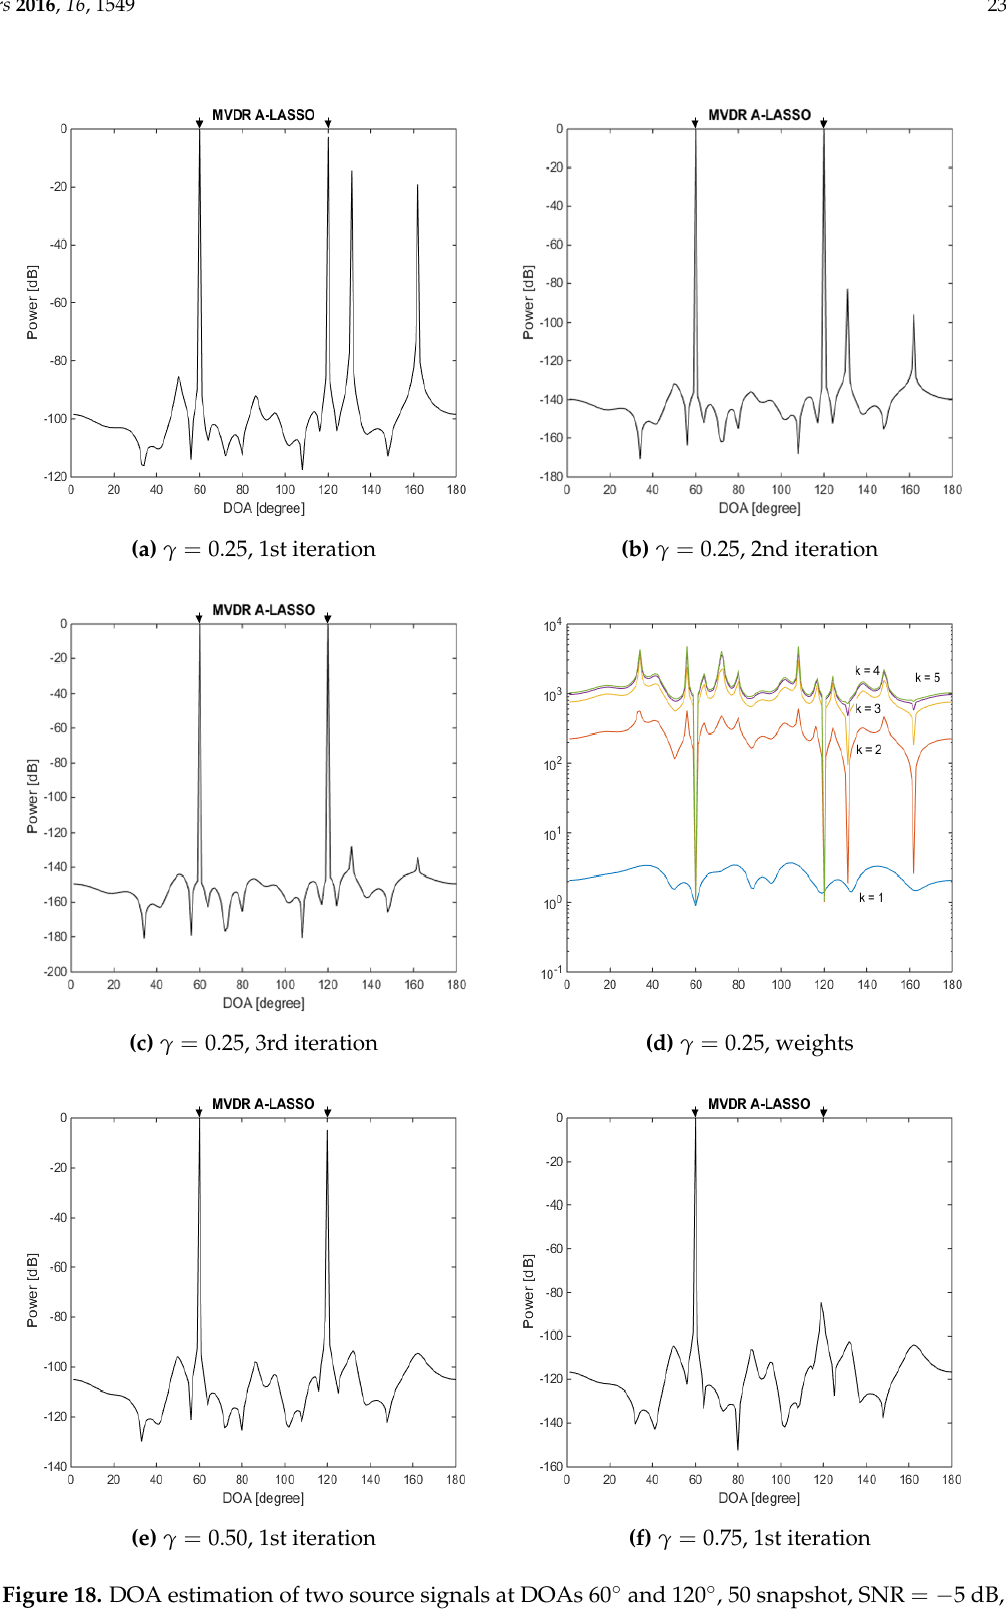
Figure 18. DOA estimation of two source signals at DOAs 60 ◦ and 120 ◦ , 50 snapshot, SNR = − 5 dB, using the MVDR A-LASSO algorithm, ( a )–( d ) γ = 0.25; ( e ) γ = 0.50; and ( f ) γ =